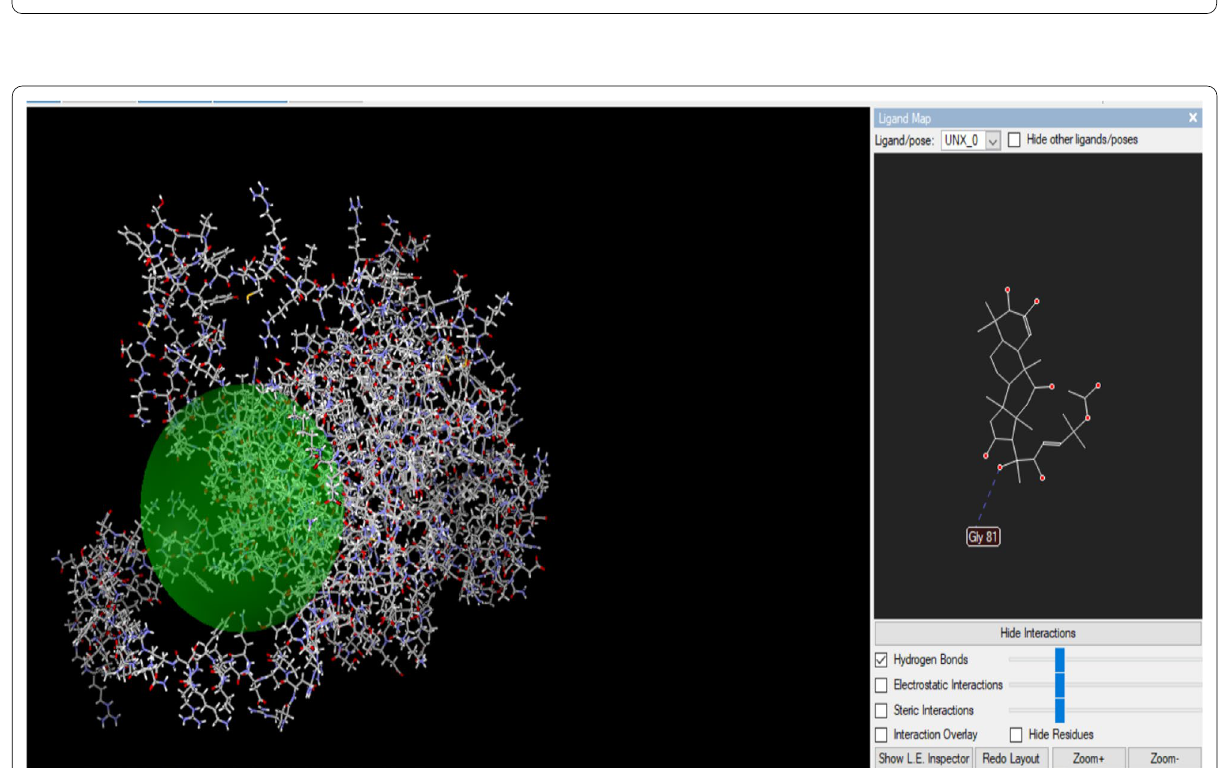
Fig. 14 The 3D representation of Cucurbitacin E at the active site of G. mellonella AChE enzyme (Hydrogen bonds; His 195, Glu 186; Thr 192; Asn 189)